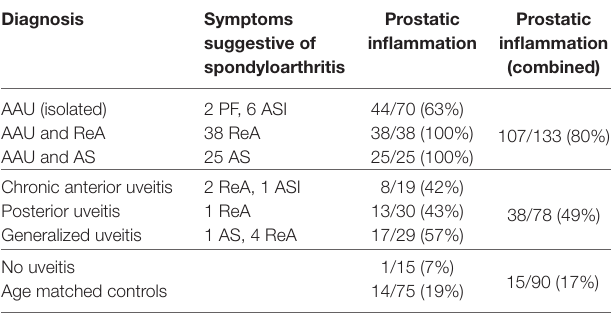
diagnosis symptoms suggestive of